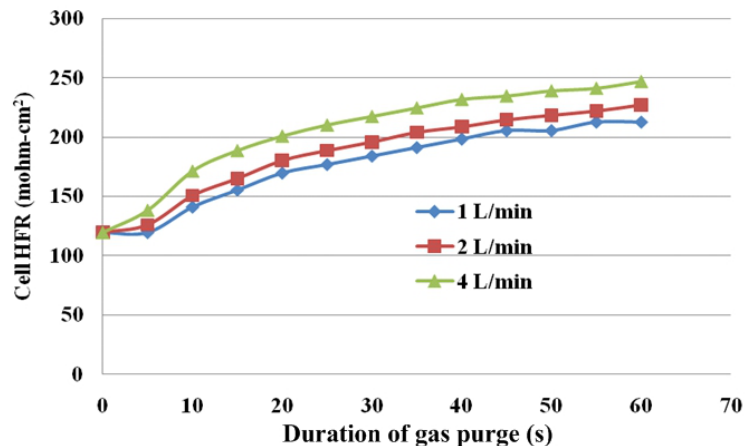
Figure 13. Local HFR variations under various purge gas flow rates—under the